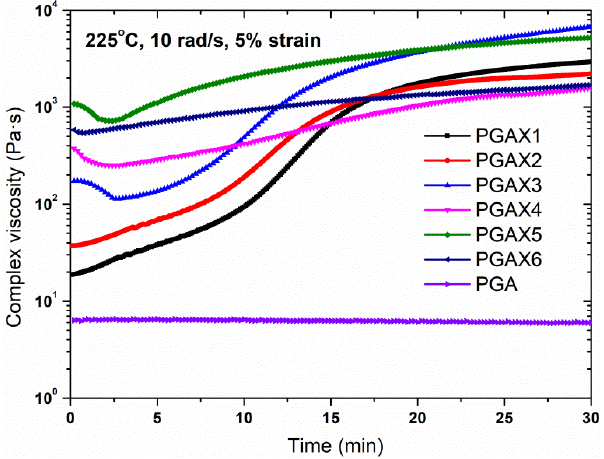
Figure 7. Isothermal shear viscosity of PGA and PGAX composites under 225 °C within 30 min.